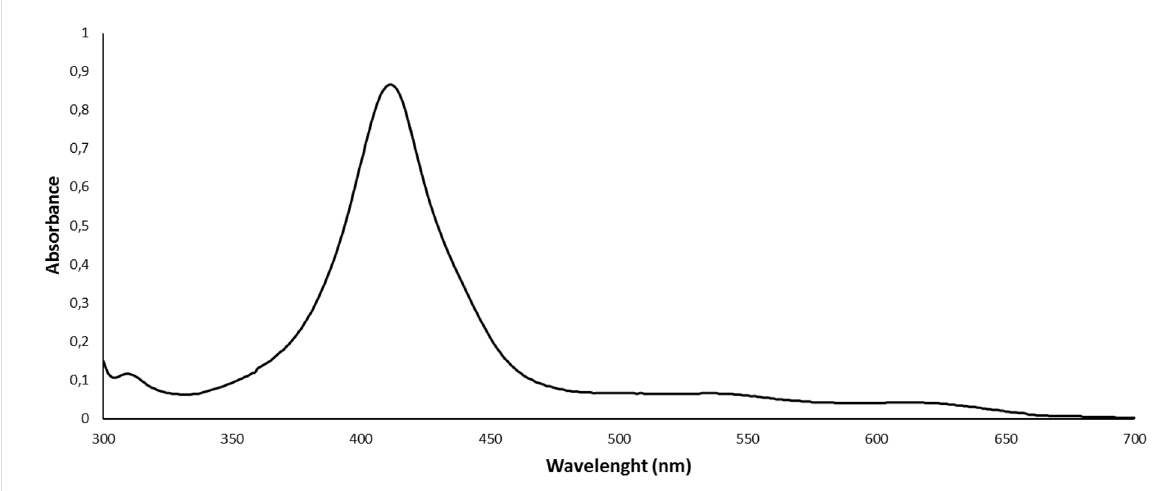
Figure 1: 1 H NMR spectrum of 2a in THF- d 8 .